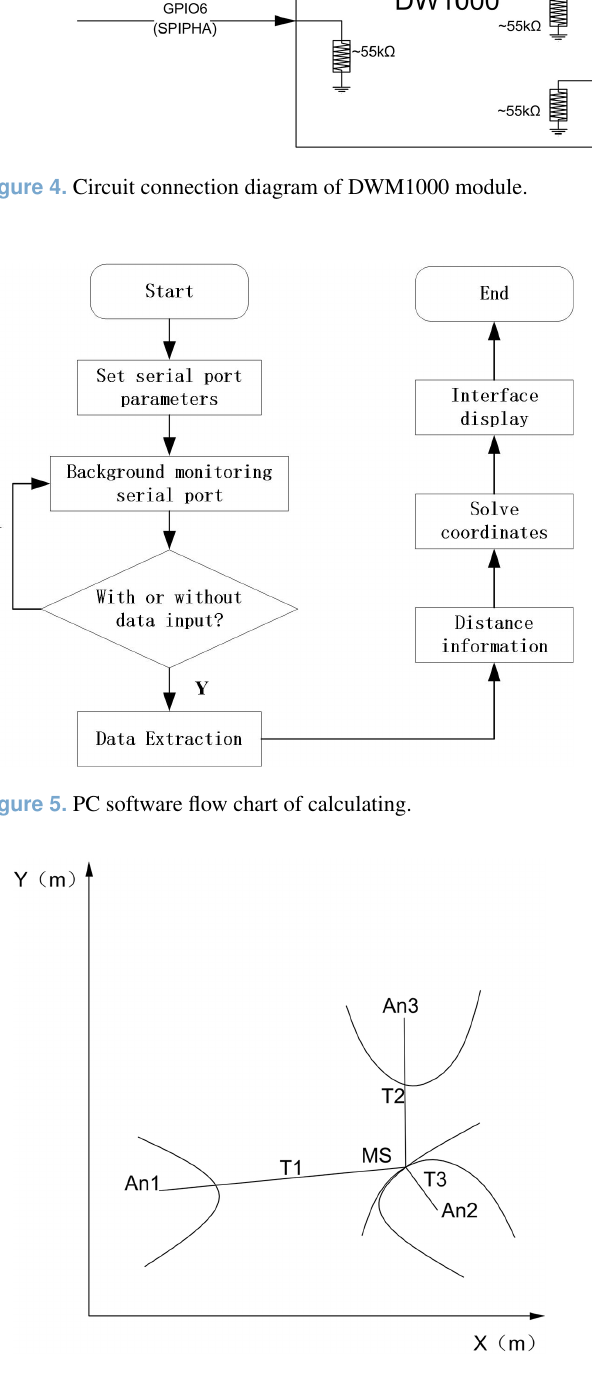
Figure 6. Schematic of TDOA positioning